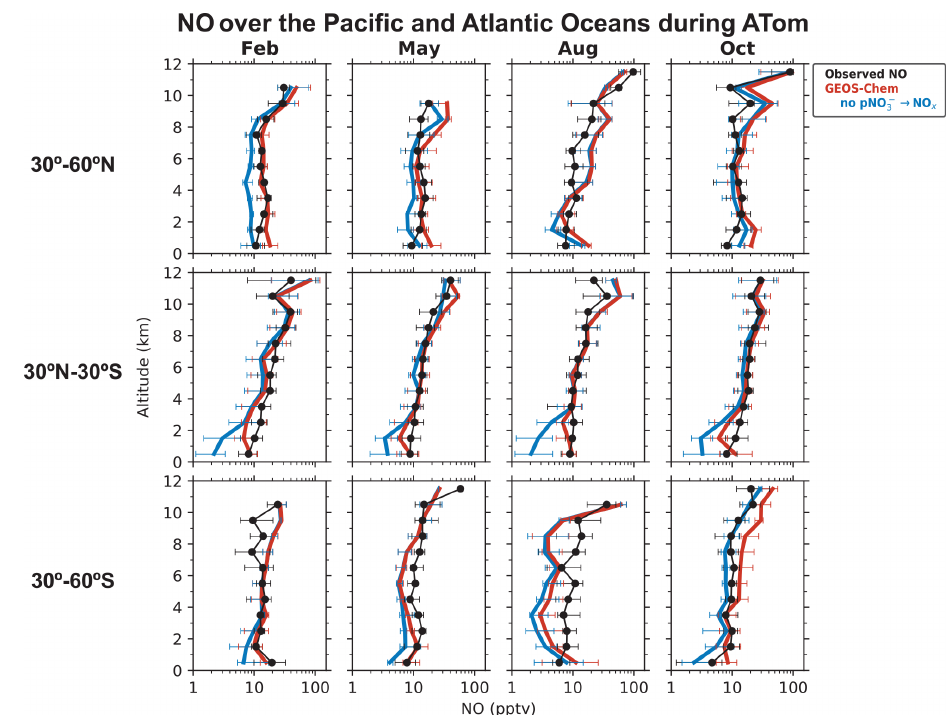
Figure 3. Median vertical profiles of NO concentrations over the Pacific and Atlantic oceans during the ATom flight campaigns (2016– 2018), separated by seasons and latitude bands. Observations (black) are from the NOAA P-CL instrument. The data selection criteria are as described in the caption of Fig. 1. Horizontal bars show the interquartile ranges in 1km altitude bins. Model results are from our baseline GEOS-Chem simulation and a sensitivity simulation without p NO − photolysis. The model is sampled along the flight tracks. NO 3 concentrations are plotted on a log scale to show the values in the lower troposphere